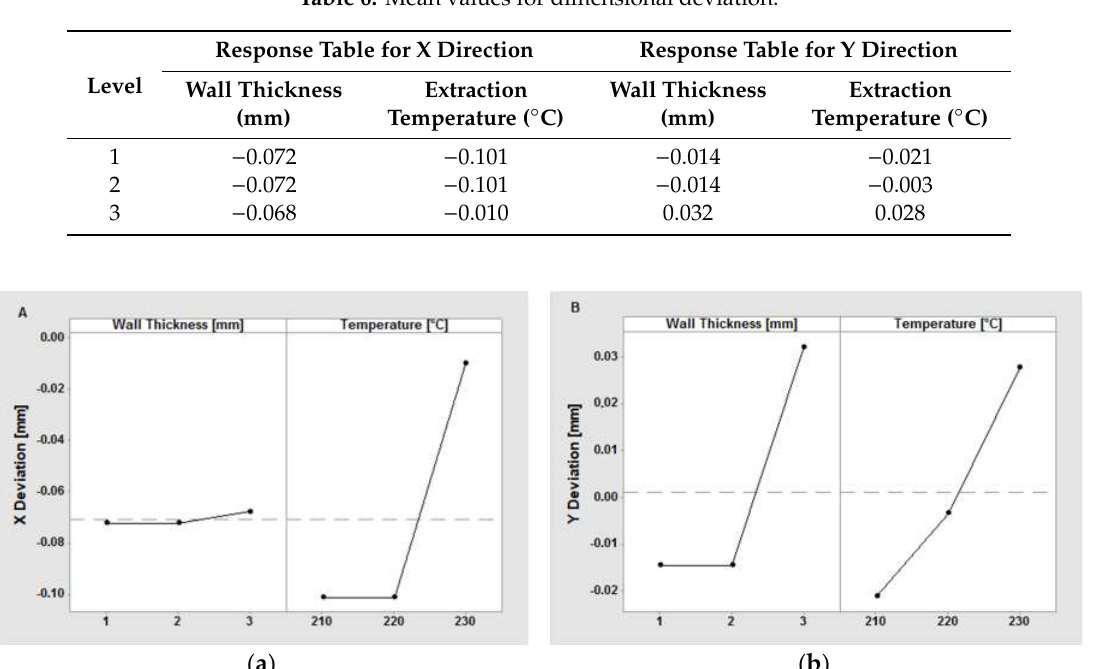
Table 6. Mean values for dimensional deviation.